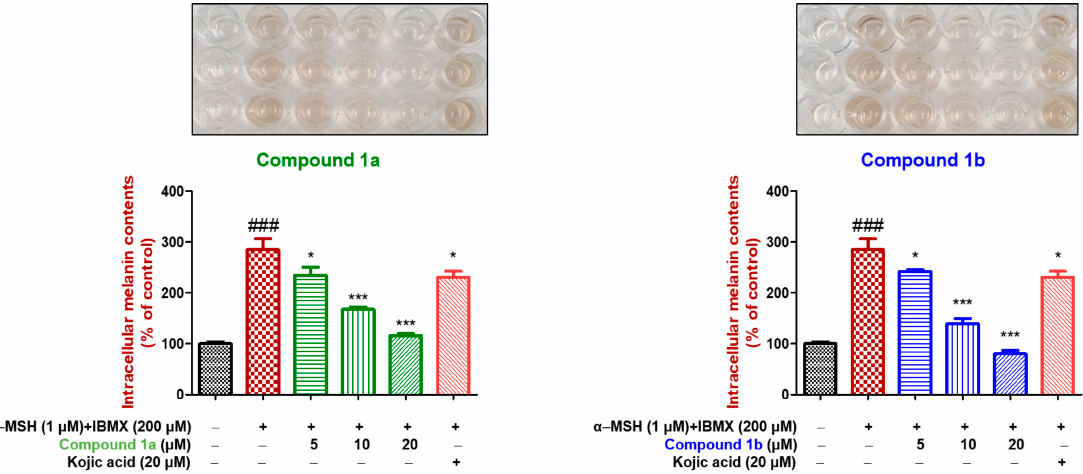
Figure 8. Effects of compounds 1a and 1b on melanin contents in the media of B16F10 cells co-stimulated with IBMX (200 μ M) and α -MSH (1 μ M). B16F10 cells were exposed to 1a or 1b of three